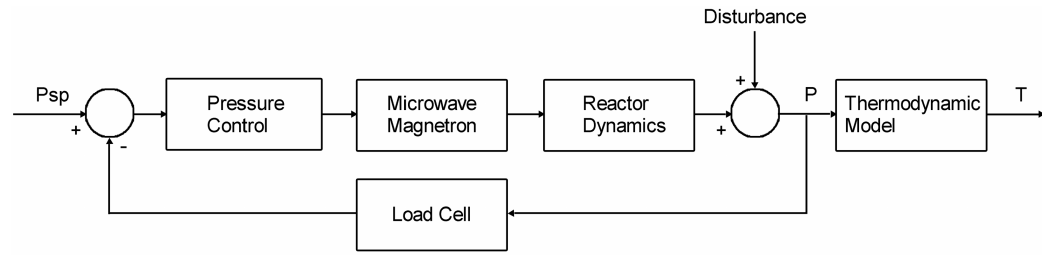
Figure 9. Block diagram of pressure P regulation system and process temperature T